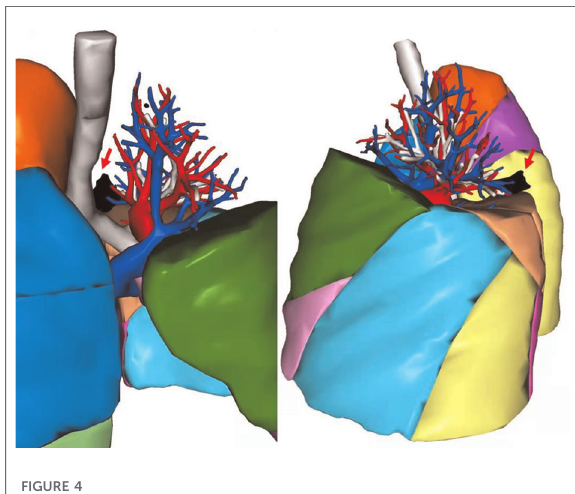
FIGURE 4 3D reconstruction of CT. Red arrows refers the lung nodule in